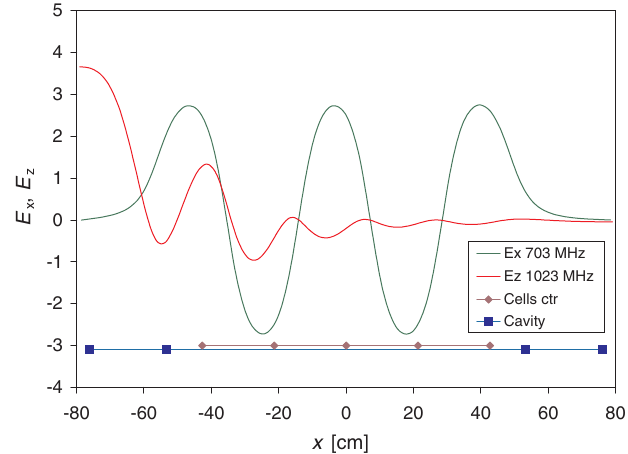
FIG. 15. Simulated accelerating field ( E X @ 703 MHz) and transverse electric field ( E Z @ 1023 MHz) of a beam tube HOM resonance in the BNL3 cavity. Also shown are the cell centers (red) and the location of the cavity with the beam tubes (blue).